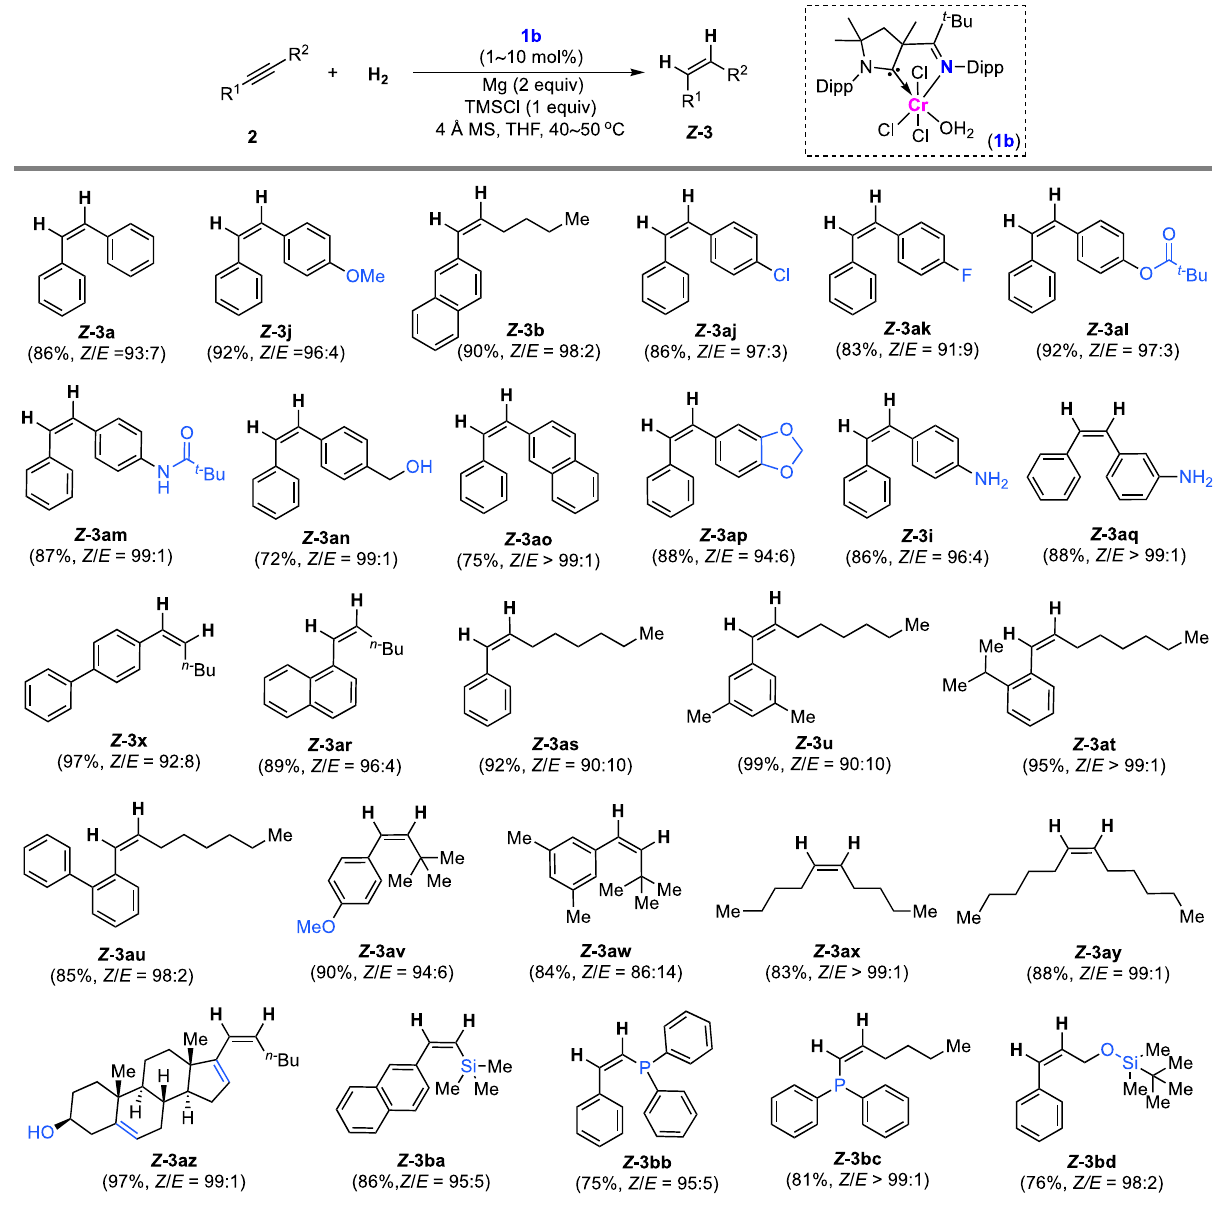
Fig. 4 | Z -selective hydrogenation of alkynes enabled by CAAC-imino ligand. Substrate scope for Z -selective hydrogenation of